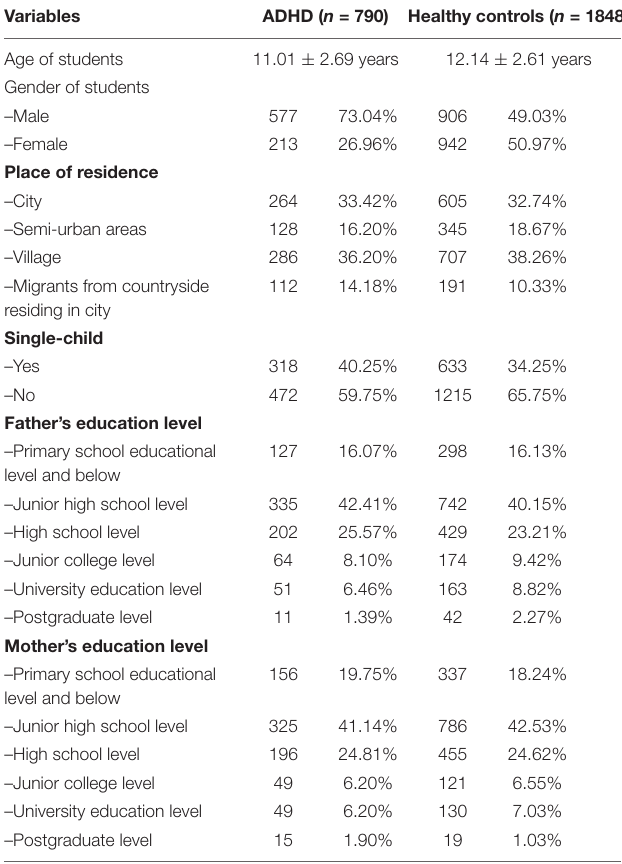
TABLE 1 | Demographic data for ADHDs and healthy controls.